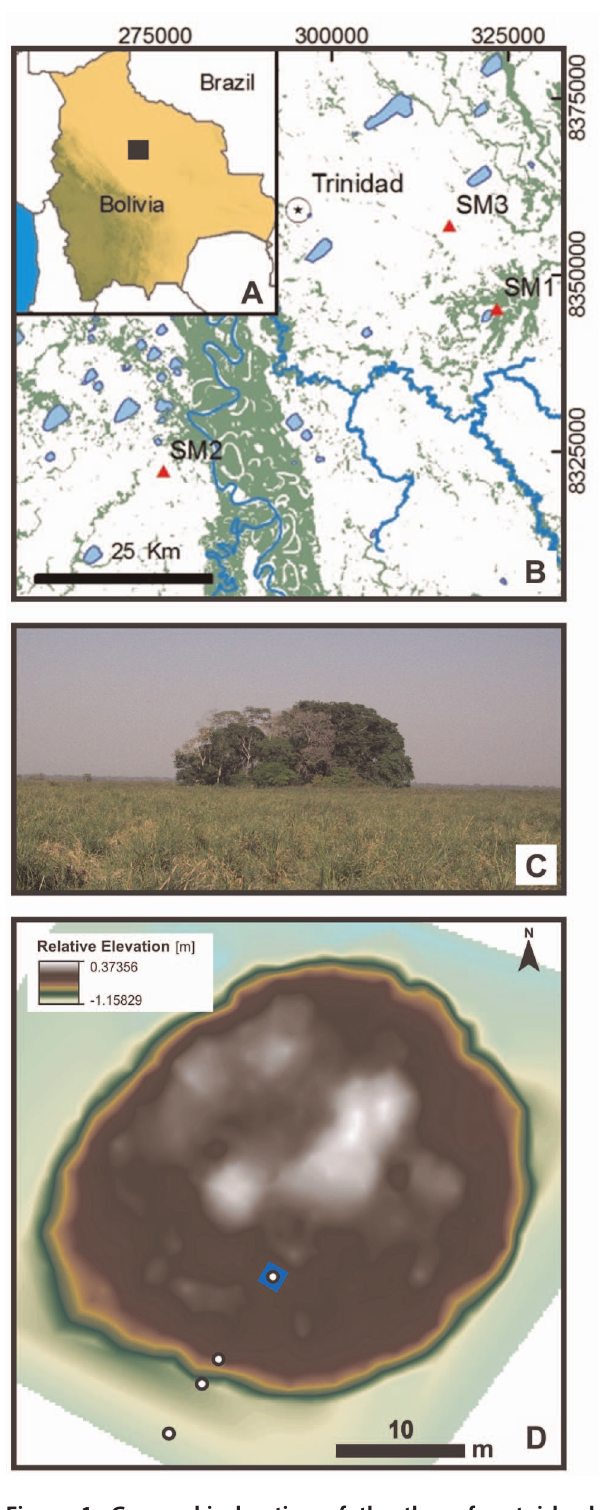
Figure 1. Geographic location of the three forest islands investigated (SM1, SM2 and SM3). a) Bolivian lowlands; b) the Llanos de Moxos; c) Panorama of SM1 (Isla del Tesoro) and surrounding savannah (view towards the SW); d) Digital Elevation Model of SM1 with the location of the 1 6 1 m test excavation (blue box) and some of the cores (white points) shown in Fig. 3.